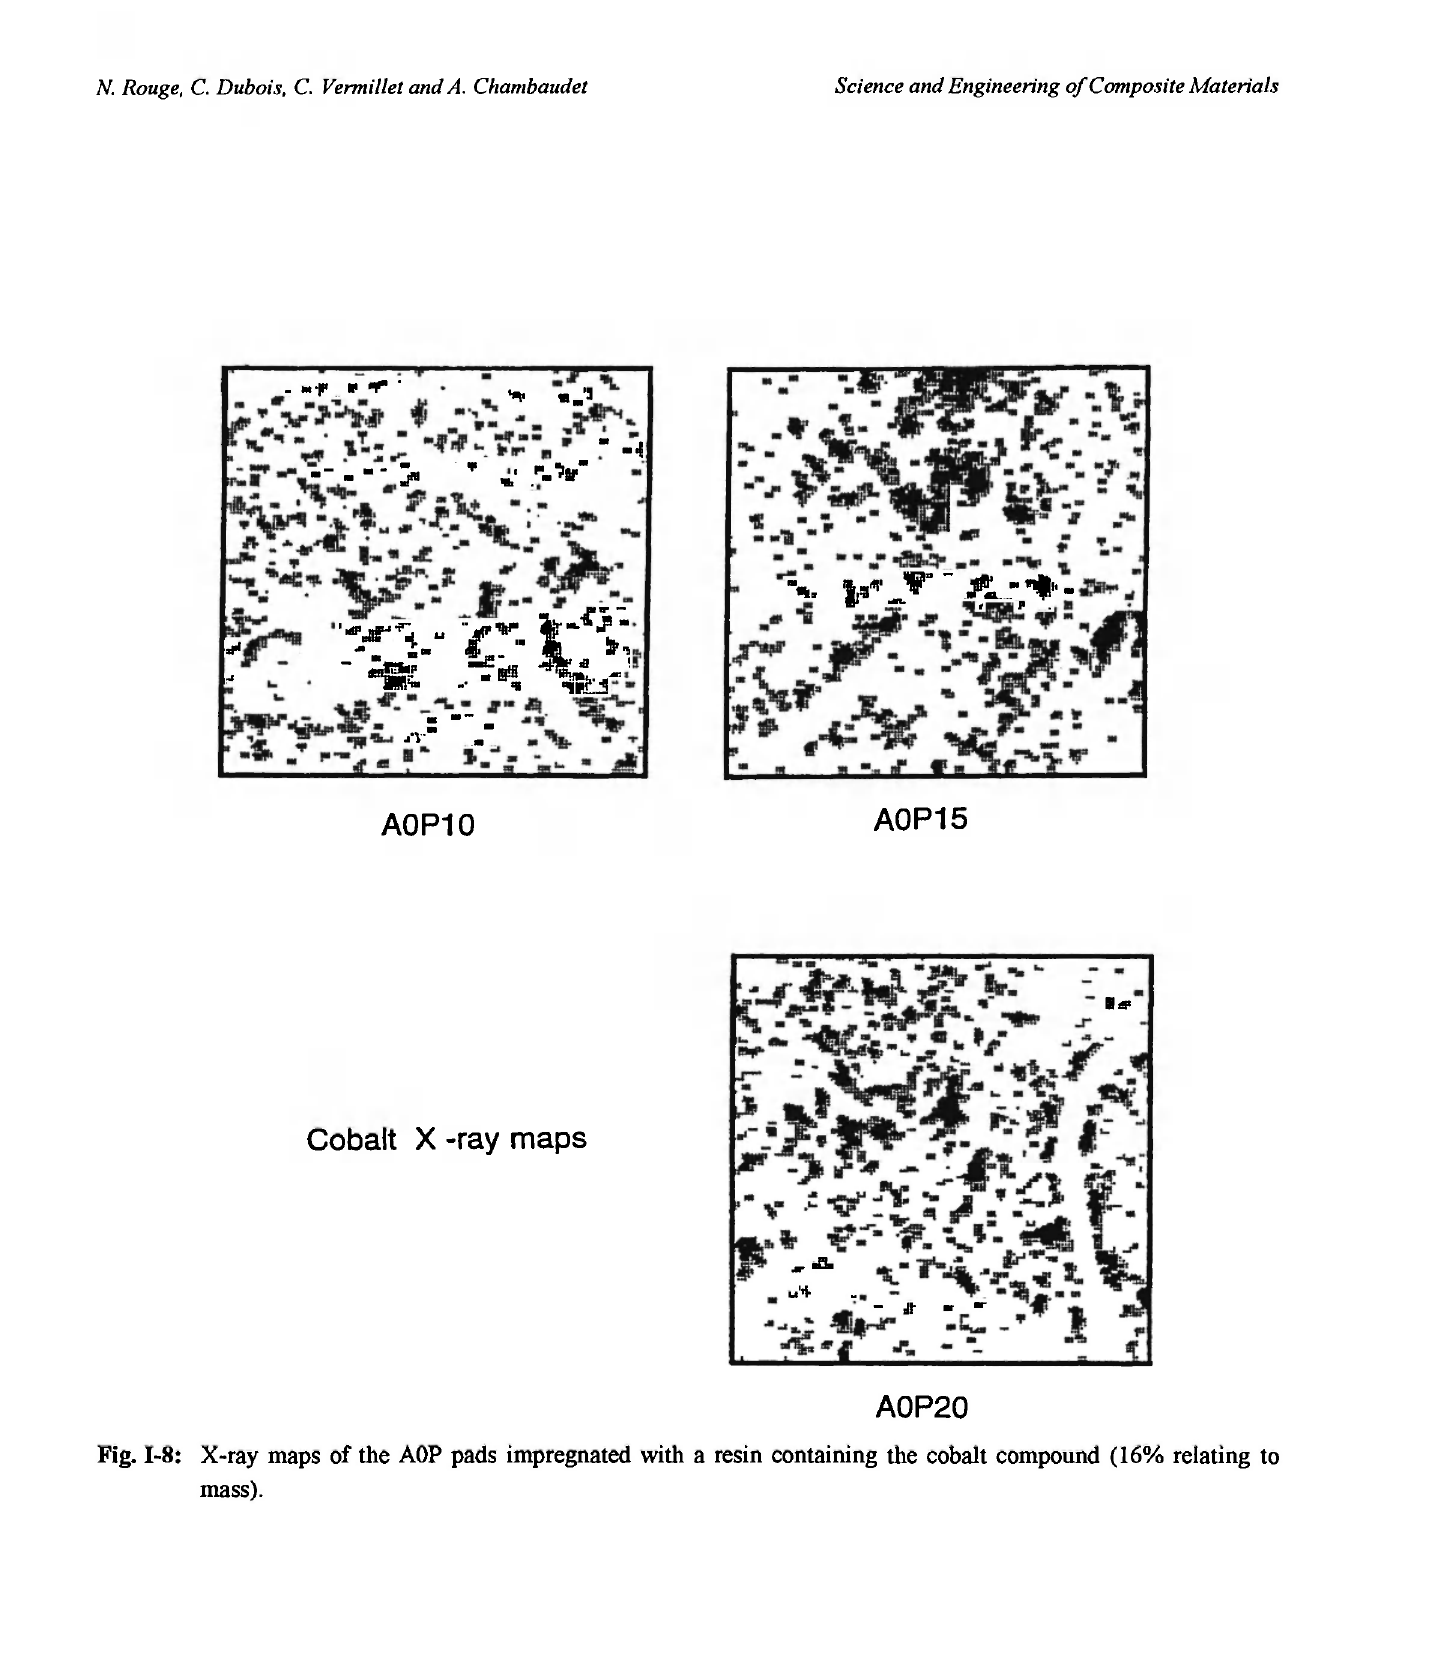
Fig. 1-8: X-ray maps of the AOP pads impregnated with a resin containing the cobalt compound (16% relating to